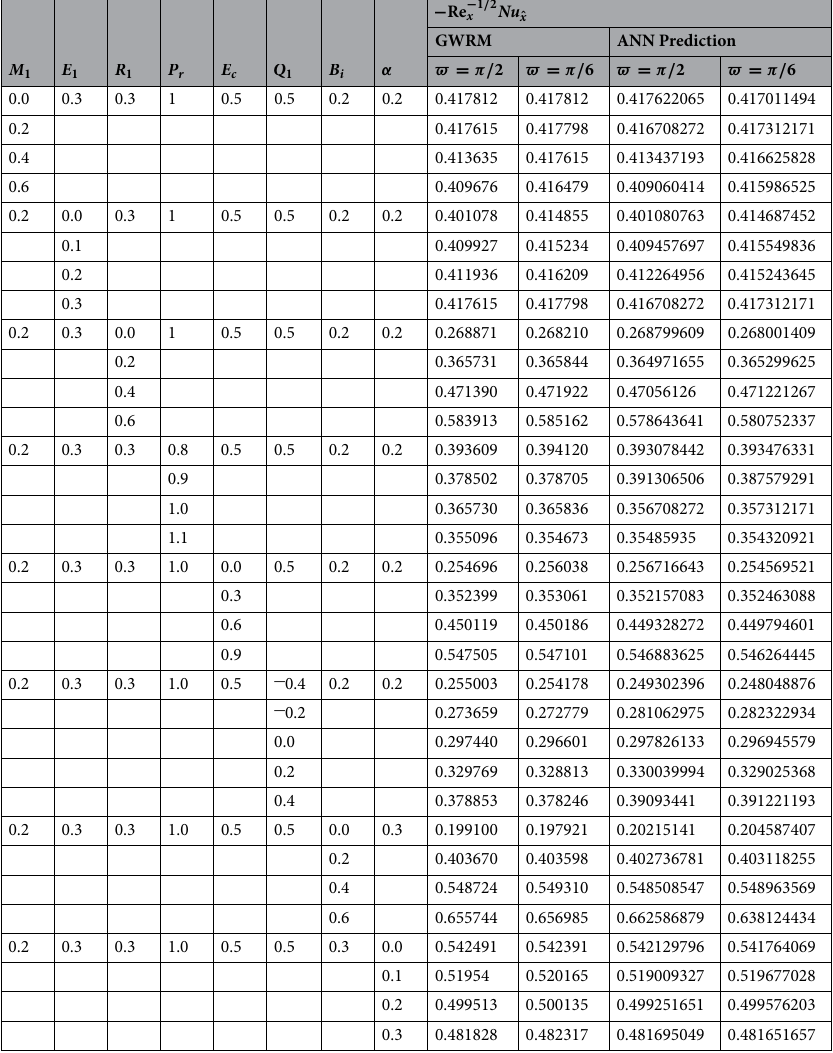
1 / 2 x Nu x for different values of physical parameters A